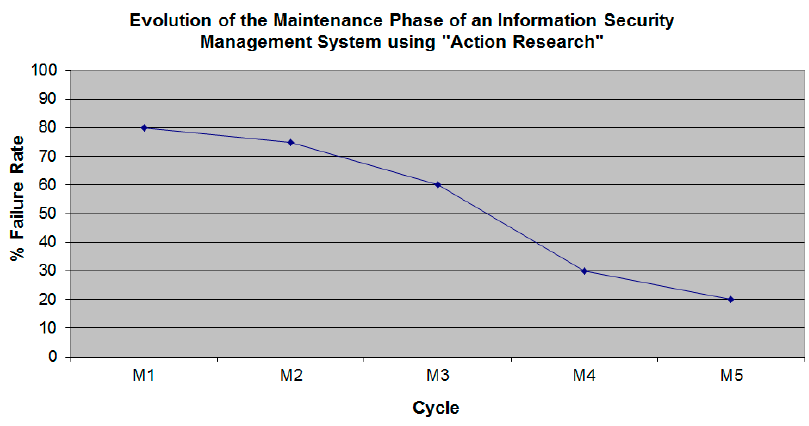
Figure 6. Evolution of the ISMS maintenance phases using AR.